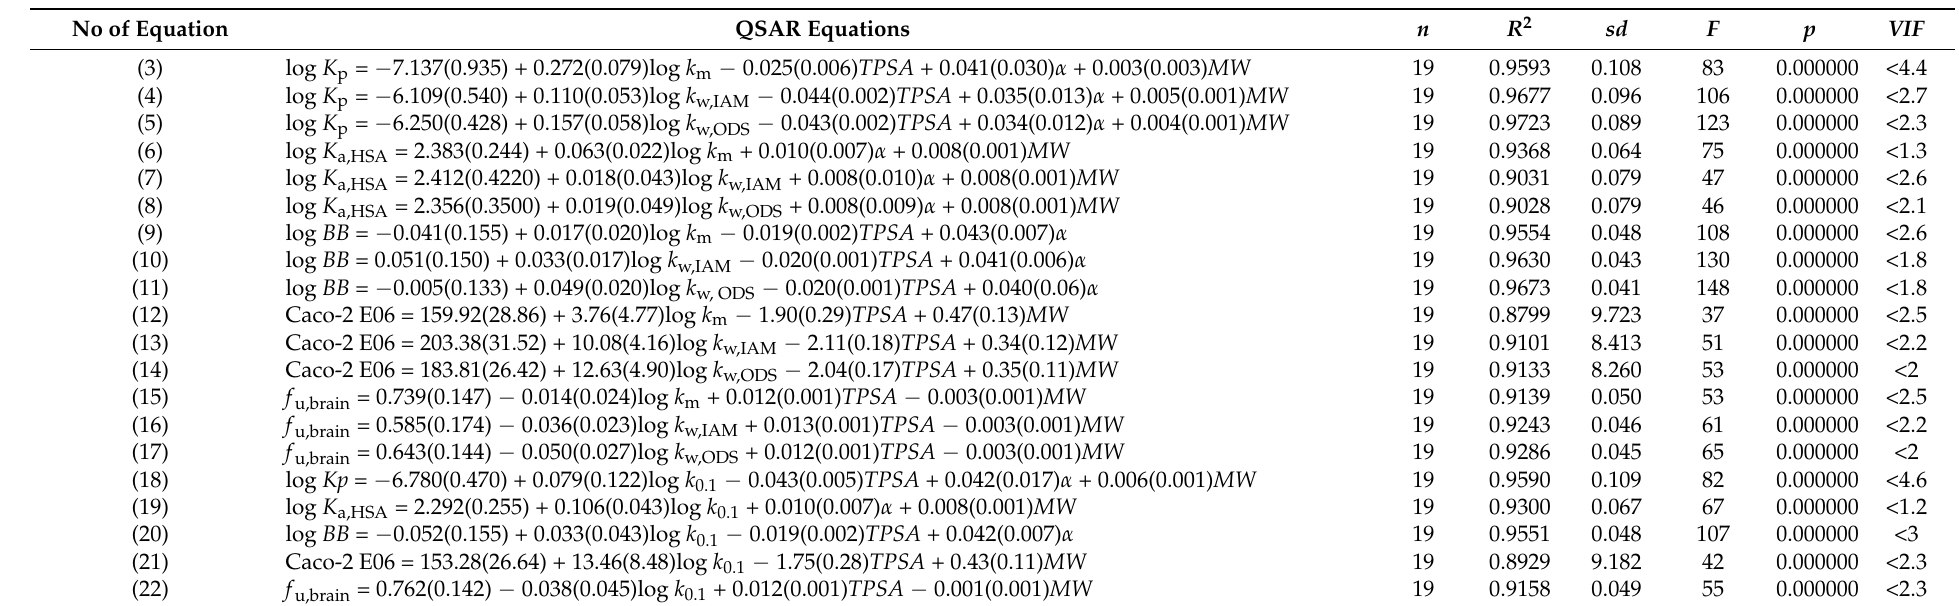
Table 3. The established Quantitative Structure-Activity Relationships ( n —number of observations, R 2 —coefficient of determination, sd —standard deviation, F -value, p —probability value, VIF —variance inflation